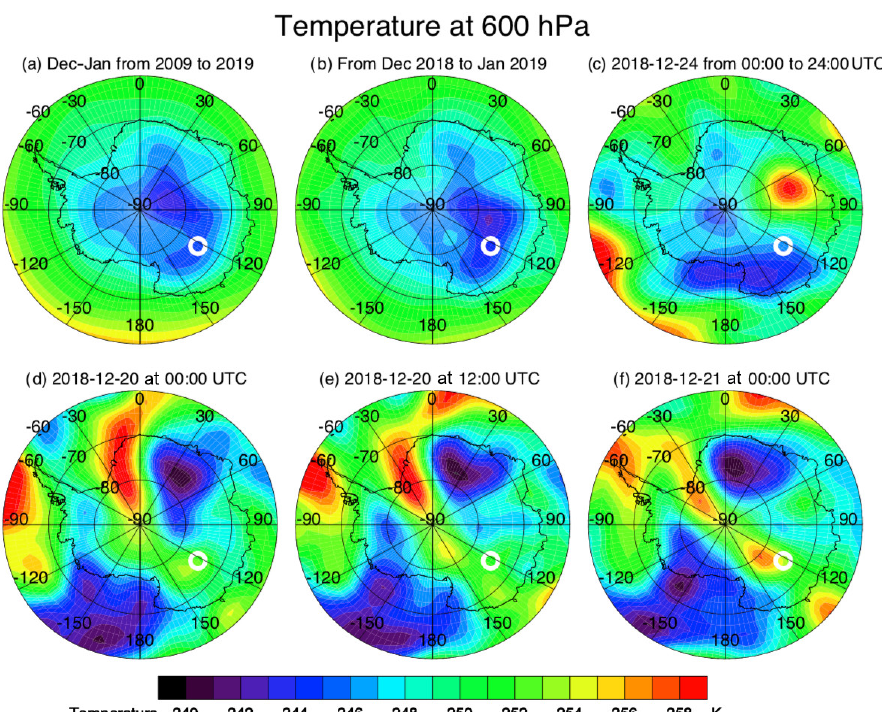
Figure 1. Temperature fields from NCEP at 600hPa: (a) decadal average over December–January from 2009 to 2019, (b) YOPP average over December 2018–January 2019, (c) daily average over 24 December 2018, (d) 20 December 2018 at 00:00UTC, (e) 20 December 2018 at 12:00UTC, and (f) 21 December 2018 at 00:00UTC. The white circle represents the position of the Dome C